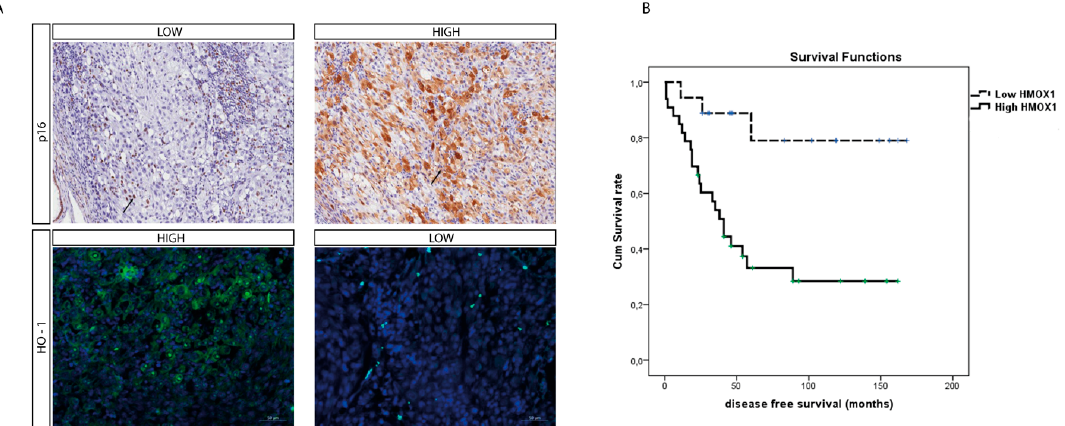
Figure 5. O-1 accumulation correlates with higher-risk UM. ( A ) Immunohistochemical expression of HO-1 anticorrelates with p16 expression in an epithelioid cell-type UM. HO-1 expression increases with the progression of this tumor, as showed by the anticorrelation with the tumor suppressor protein p16. (immunoperoxidase; original magnification 200 × ). ( B ) Kaplan–Meier survival curves in UM patients. Disease-free survival decreases when HO-1 is